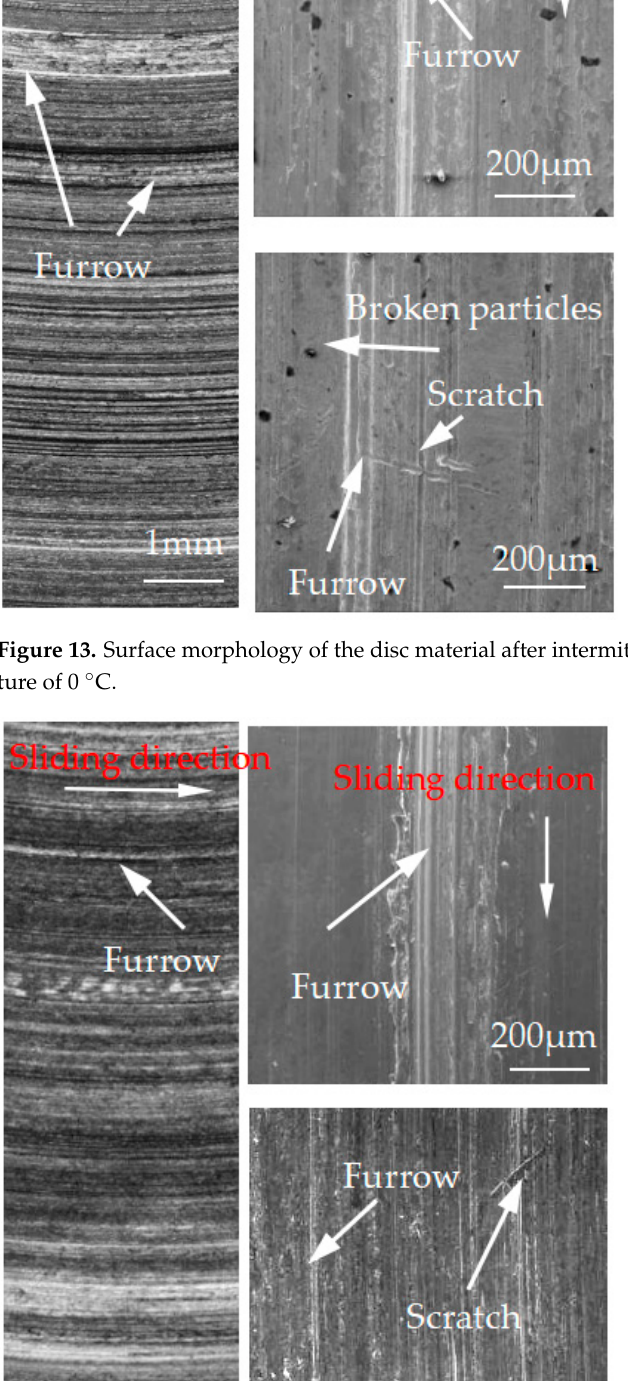
Figure 14. Surface morphology of the disc material after intermittent braking at an ambient temper- ature of − 10 °C.